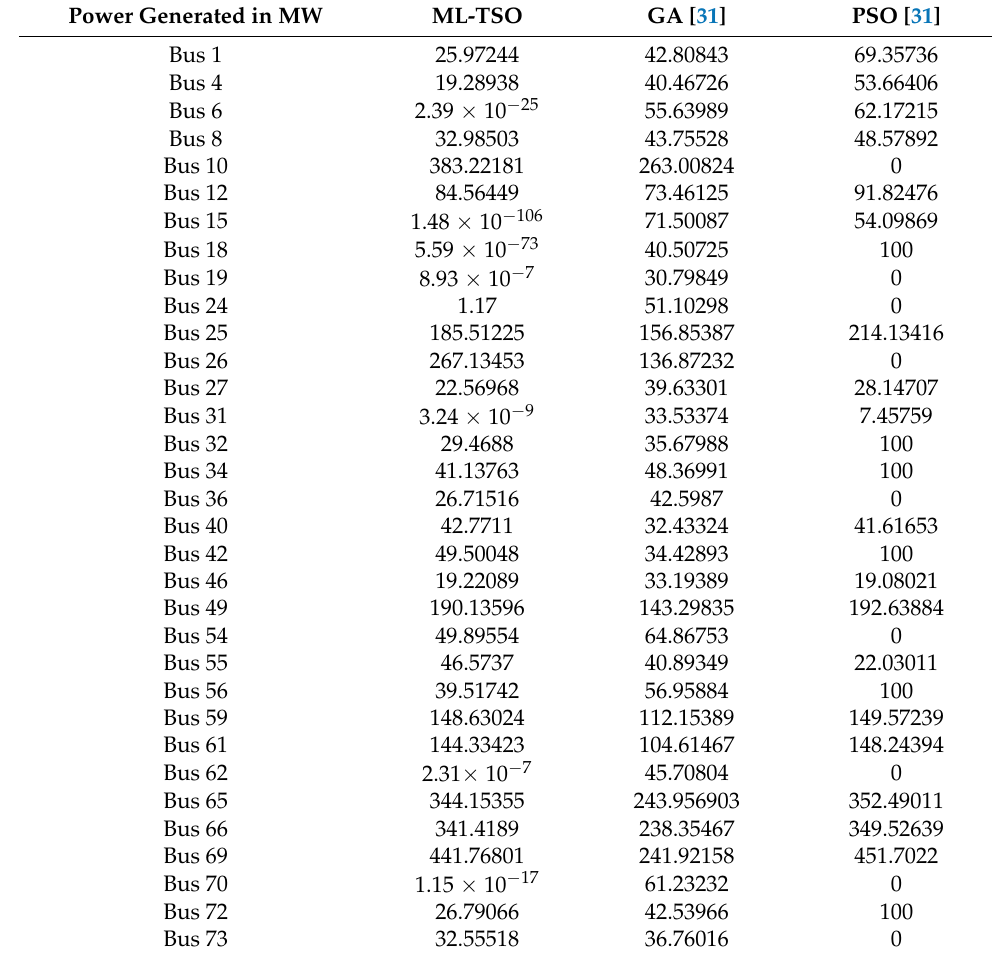
Table 6. Minimum fuel cost and optimal design variables for the IEEE 118-bus